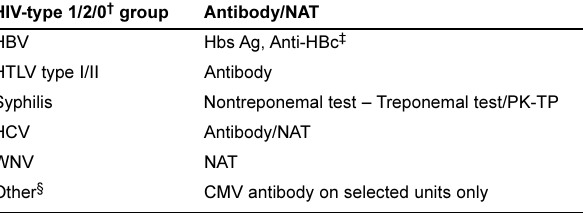
TABLE 1 Testing of blood donors in Canada* by Canadian Blood Services (CBS) and